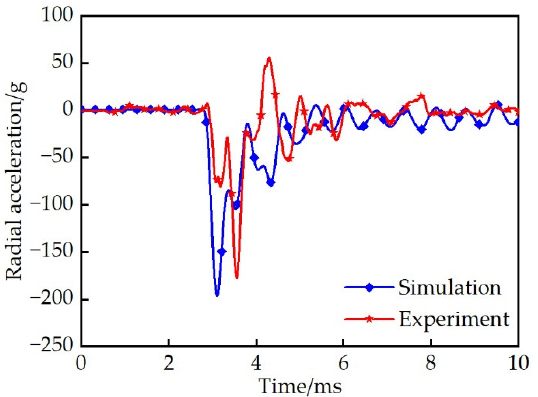
Figure 7. Comparison of radial acceleration between experiment and simulation.